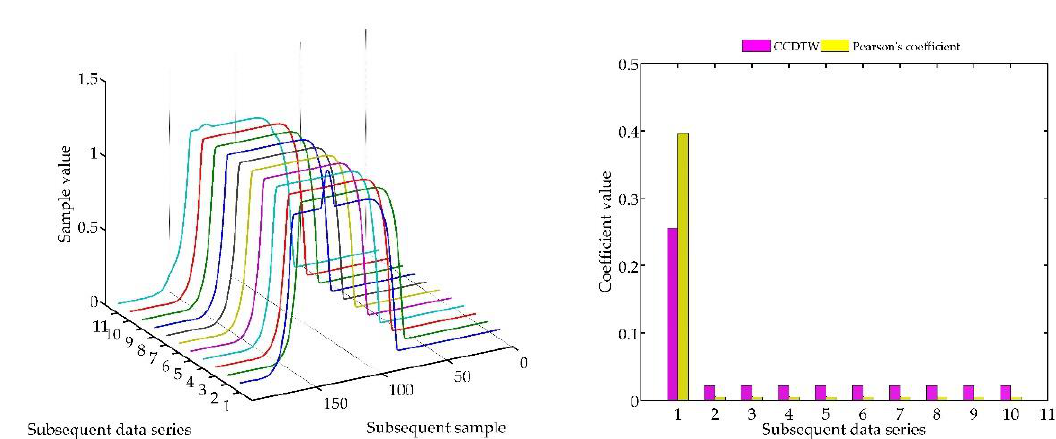
Figure 21. Simulation results achieved for data shifted by +15 samples for the first series (blue line) for r ampl = 2.